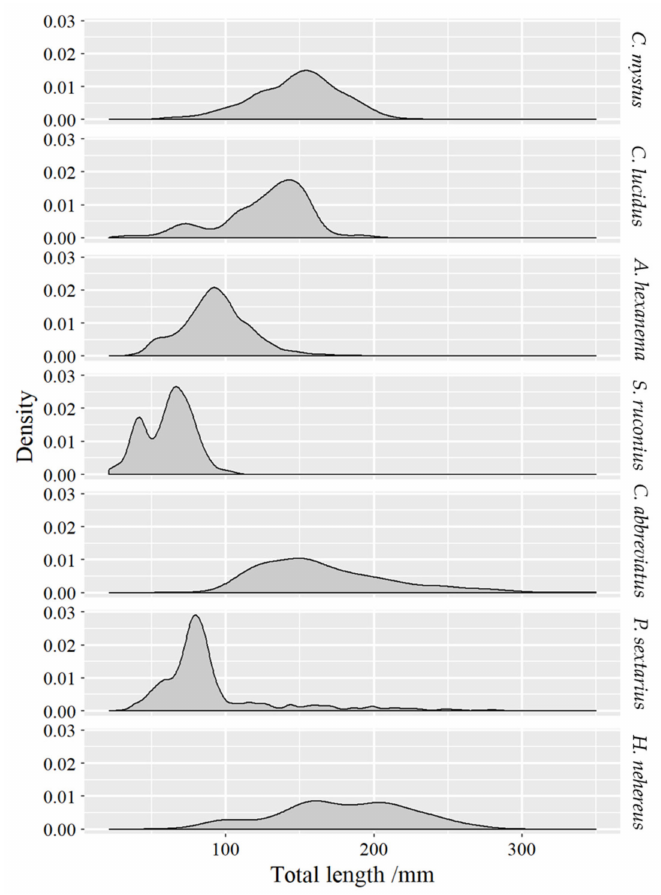
Figure 2. Probability density curve of length distribution for seven dominant fishes in the Min River Estuary during